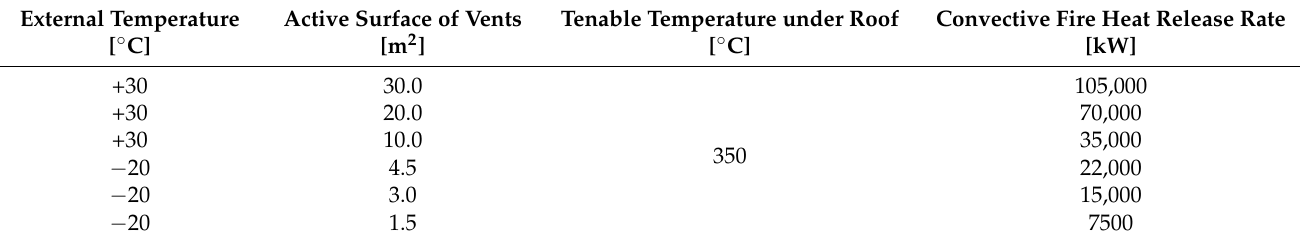
Table 5. The required vents area for keeping under the turbine house’s roof temperature below 350 ◦ C in a fire